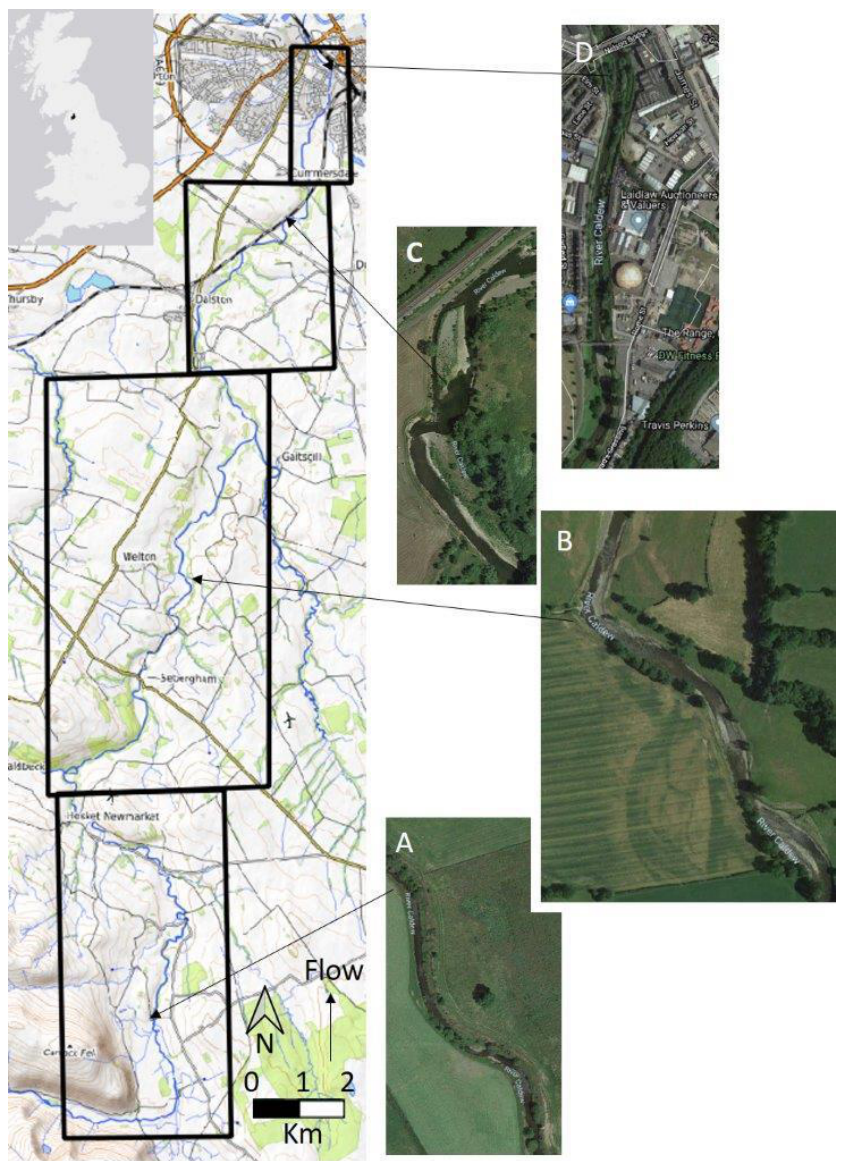
Figure 1. Study reach of River Caldew, Cumbria UK with the reach split into four sections with inset images displaying typical channel types at arrowed locations by Google Earth: Reach 1 Mosedale to Hesketh Bridge ( A —engineered urban single thread), Reach 2 Hesketh Bridge to Buckabank ( B — Recovering sinuous single thread), Reach 3 Buckabank to Cummersdale where the river is gauged ( C —incipient wandering), Reach 4 Cummersdale to Bridge St in Carlisle ( D —historically channelized restricted sinuous single thread), imagery © OpenStreetMap/Maxar Technologies/Google.